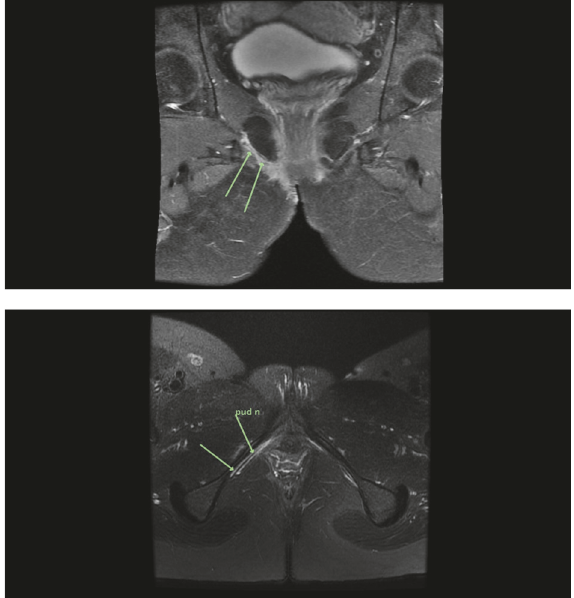
Figure 3: Postoperative T2 axial MRI through the pelvis demon- strating high T2 signal in the right pudendal